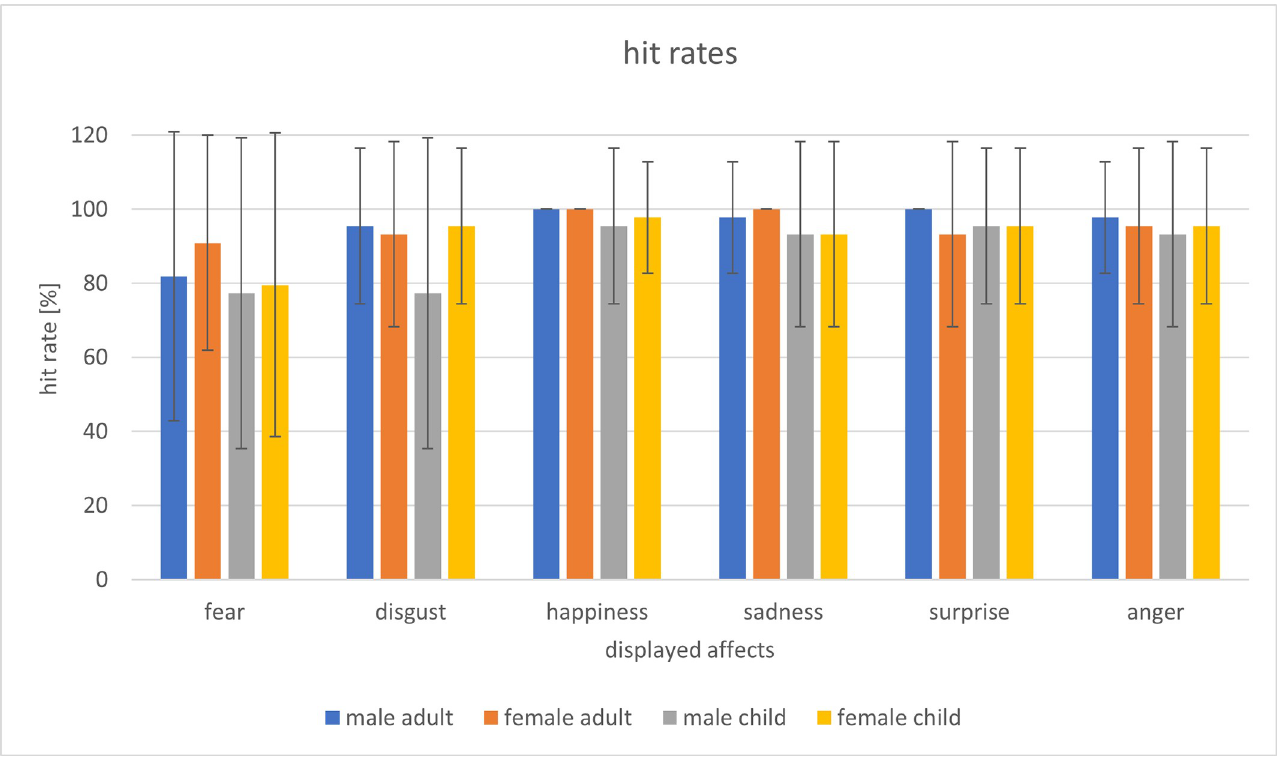
Fig 3. Hit rates of the affect prototypical reference pictures of the six basic affects of male and female adults and children. The error bars represent standard deviations. Since all participants recognized the portraits “happiness male / female adult”, “sadness female adult” and “surprise male adult” 100% correctly, the standard deviations were